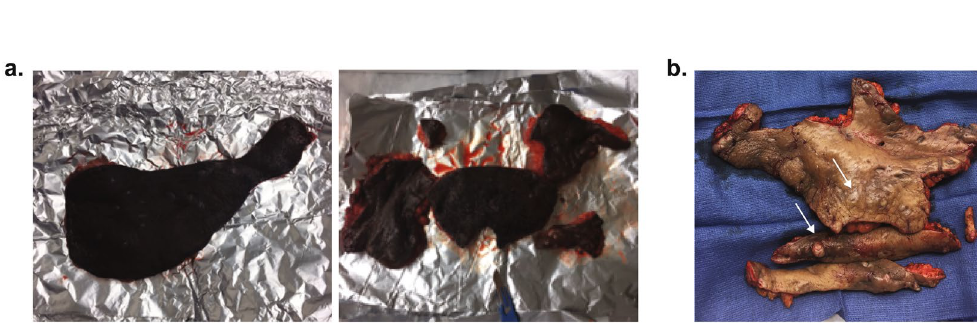
Figure 5. ( a ) A large piece of freshly resected HS tissue on foil ( left ). The tissue can be further sectioned using a scalpel to enable proper storage and further studies ( right ). (b) Arrows indicate areas of apparent nodules and lesions on freshly resected HS tissue.